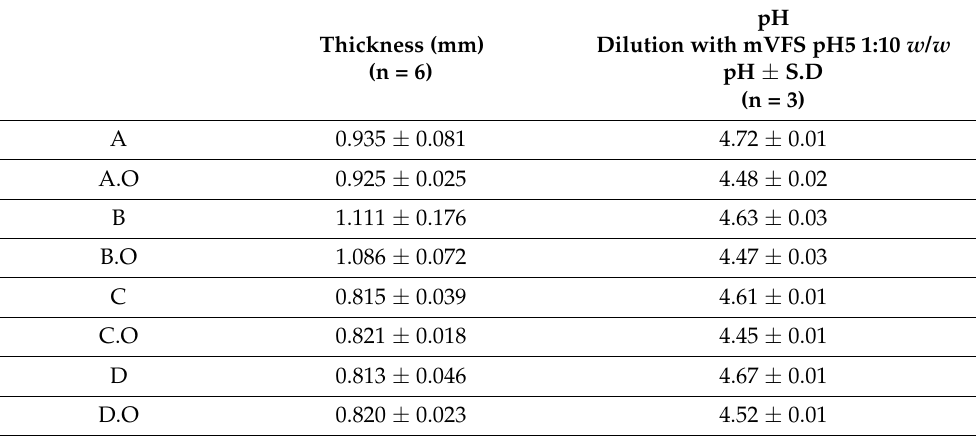
Table 2. Thickness (mm) and pH after diluting vaginal sheets in vaginal fluid simulant with mucin (mVFS) pH 5 (1:10 w/w